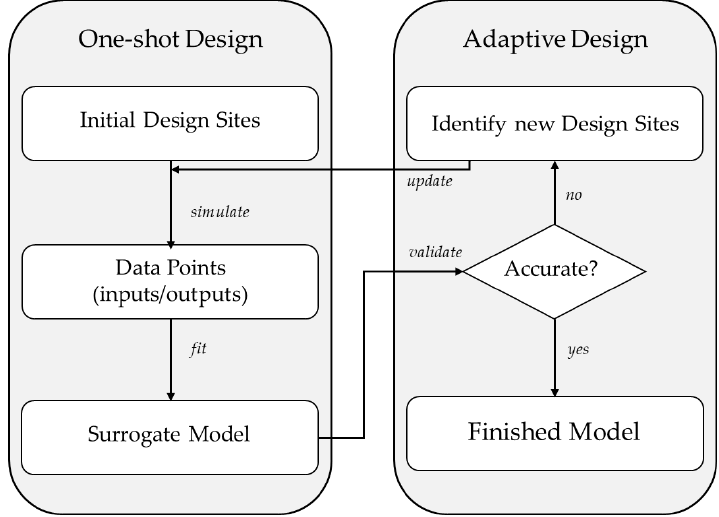
Figure 6. Comparison of the main steps of stationary and adaptive sampling processes based on [53].